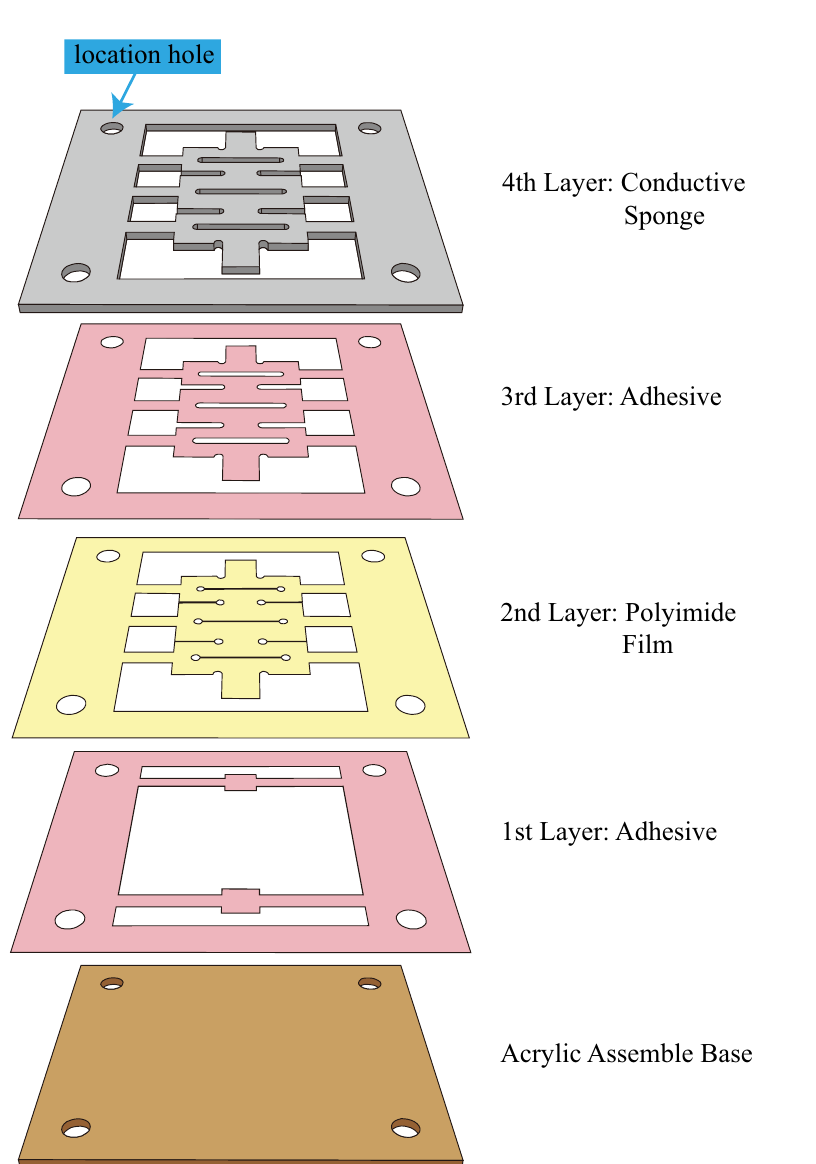
Figure 2. Planer fabrication process of kirigami-inspired flexible sponge sensors. Order of layers and location holes for fabrication are